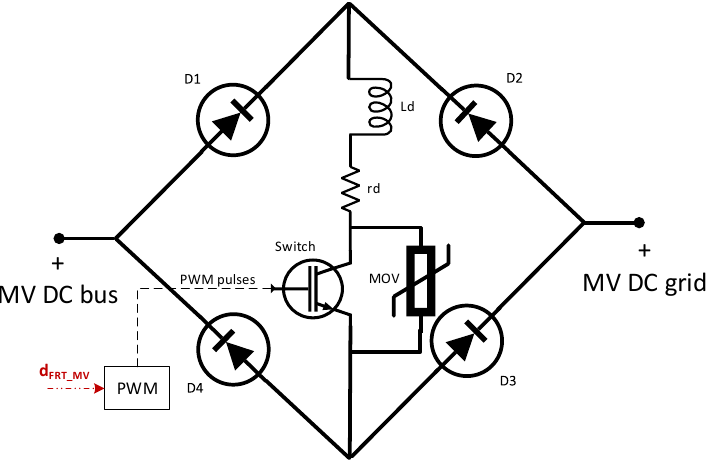
Figure 5. Detailed diagram of the electronic